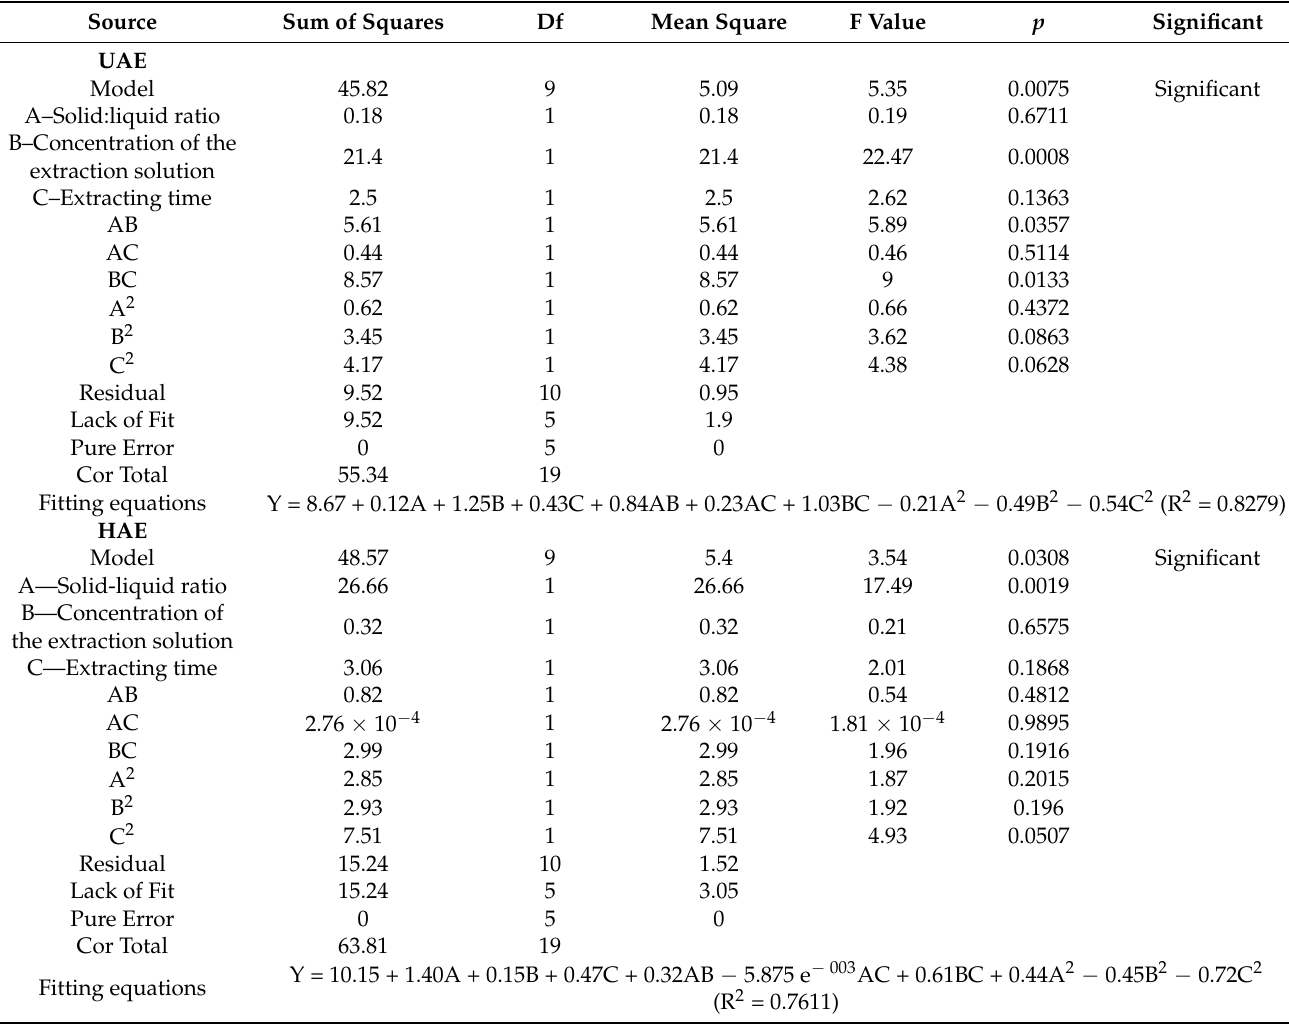
Figure 4. Ultrafiltration high-performance liquid chromatography chromatograms of the lactate dehydrogenase (LDH) inhibitors present in the crude sample of Inonotus obliquus (detection wavelength: 300 nm). (A) 20 U/mL LDH; (B) 10 U/mL LDH; (C) 5 U/mL LDH; (D) blank. Table 2. Analysis of variance of the quadratic multiple regression